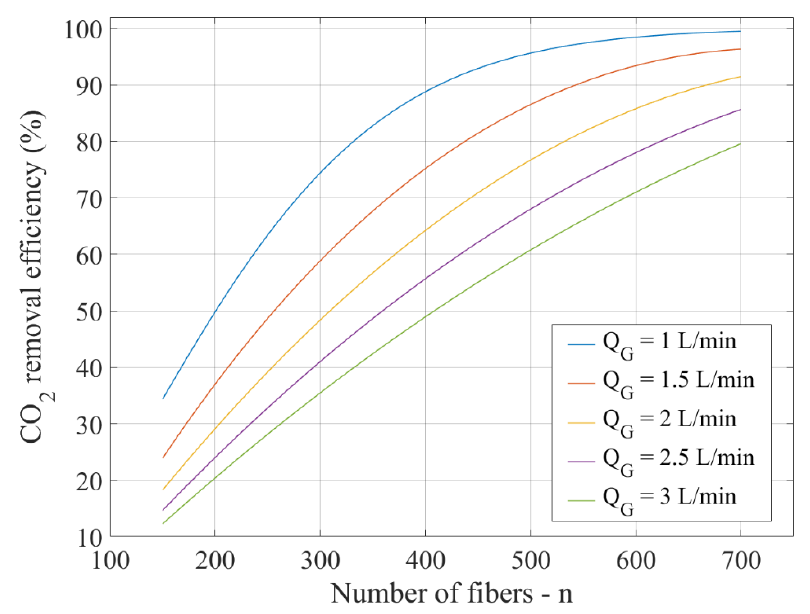
Figure 9. Effect of the number of fibers on the CO 2 removal efficiency at different gas flow rates, Q L = 25L · h − 1